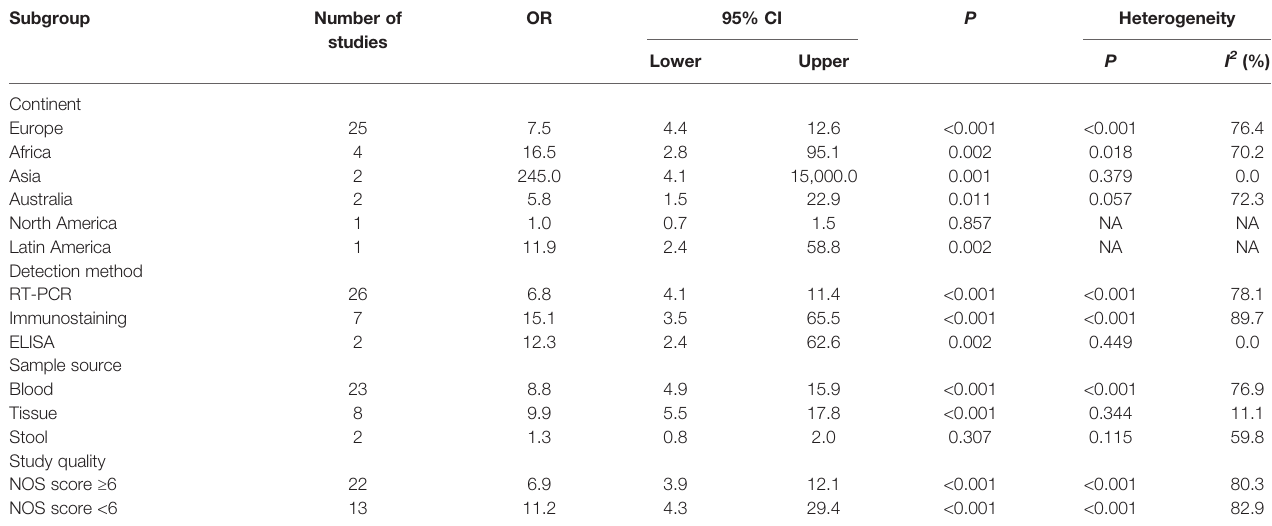
TABLE 2 | Subgroup analysis results.